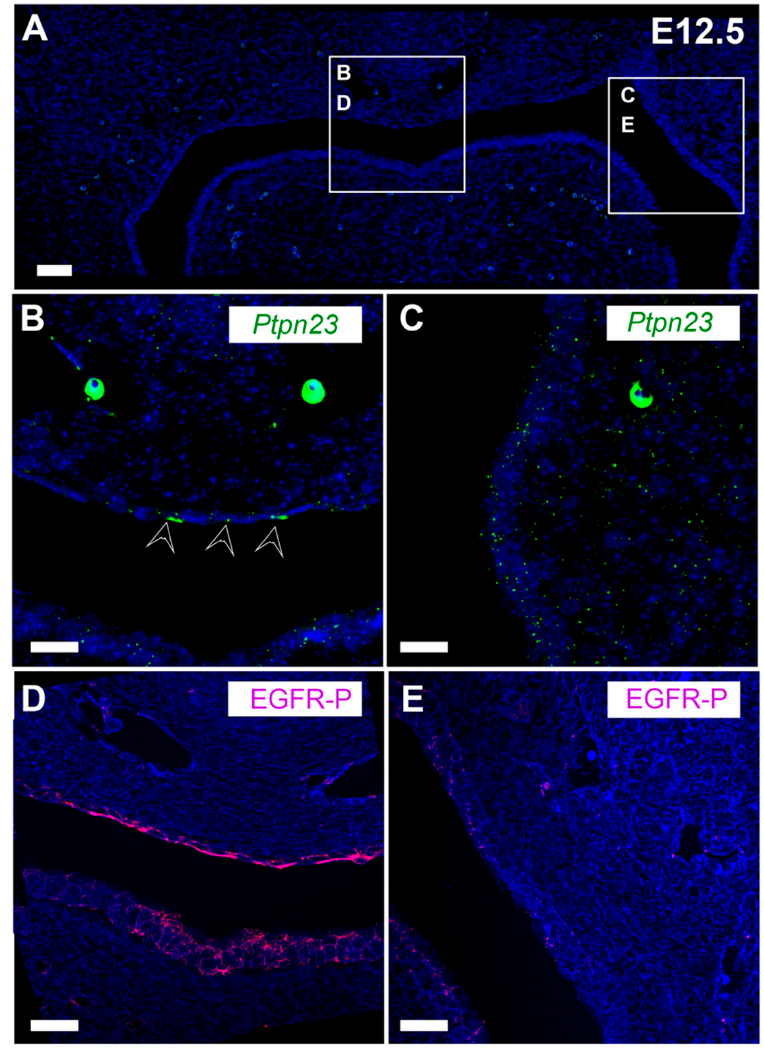
Figure 7. Expression of PTPN23 and EGFR in the oral cavity. Murine E12.5 frontal sections at the midline at the upper incisors. Serial sections used for PTPN23 and EGFR. ( A ) DAPI (blue) stained section highlighting regions shown in ( B – E ). ( B , C ) PTPN23 RNAscope. Signal shows up as green dots. Large circular patches are autofluorescence from blood cells. ( D , E ) Immunofluorescence EGFR protein in pink. ( B ) PTPN23 is expressed in the midline epithelium (arrows) and ( C ) robustly in the more lateral epithelium and mesenchyme. ( D ) EGFR is expressed in the midline in the forming incisor region, similar to PTPN23 expression. ( E ) EGFR is weakly expressed more laterally. Scale bar in ( A ): 100 µ m. Scale bar in ( B – E ): 50 µ